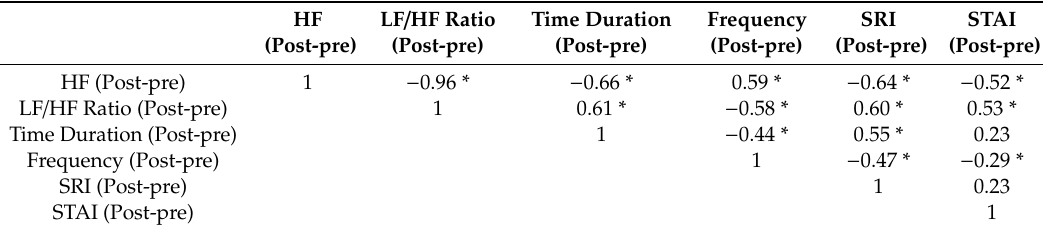
Table 7. Pearson correlation coe ffi cients between autonomic balance, bowel movement frequency and time–duration and psychological factors. (N = 54). HF